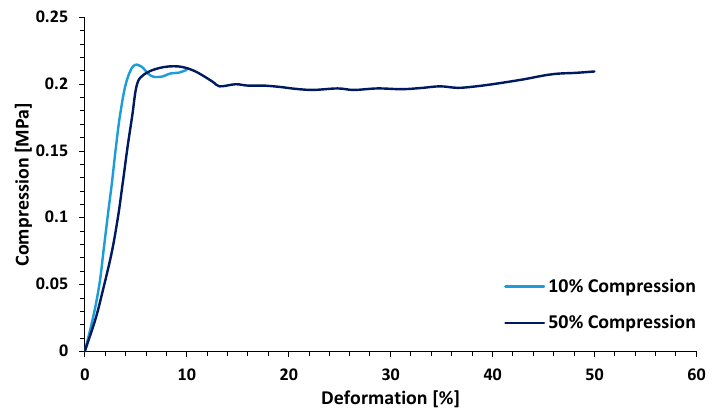
Figure 10. Foam stress–strain curve under compression.